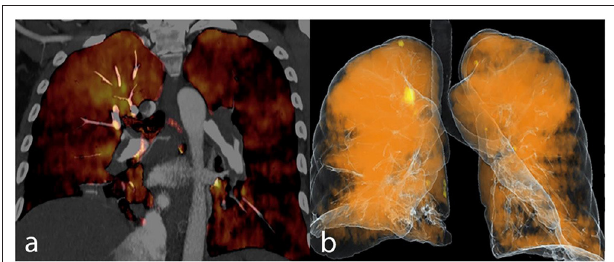
Baseline and cardiologic characteristics are summarized